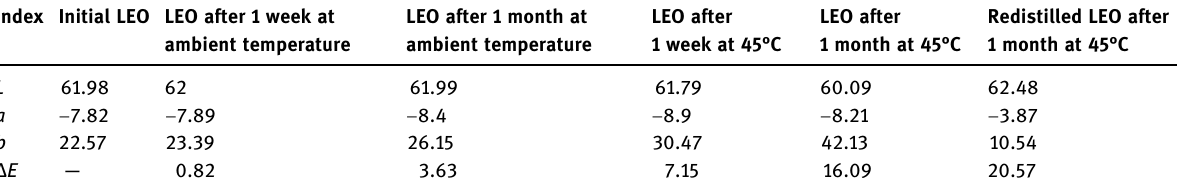
Table 1: Color changes of LEO under di ff erent storage and extraction conditions Index Initial LEO LEO after 1 week